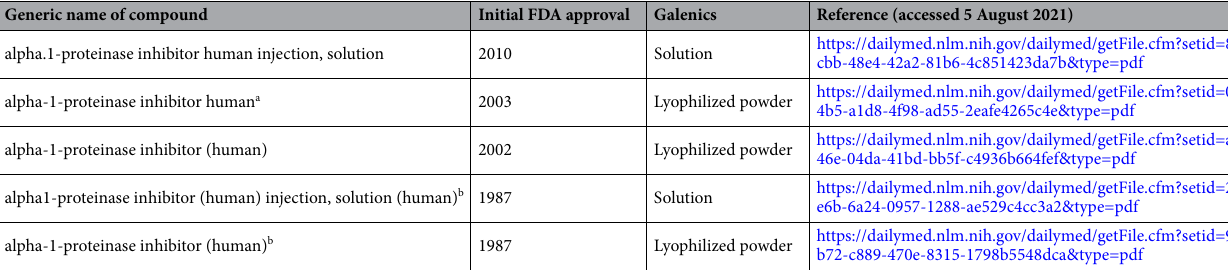
Table 2. FDA approved compounds for the treatment of alpha-1-antitypsin deficiency in reverse chronological order by year of FDA approval. Close of database 5 August 2021. a Alpha1-proteinase inhibitor (human) sponsored by the same manufacturer received orphan drug designation which was subsequently withdrawn (Table 1). b Both compounds were listed with very similar trade names in the FDA orphan